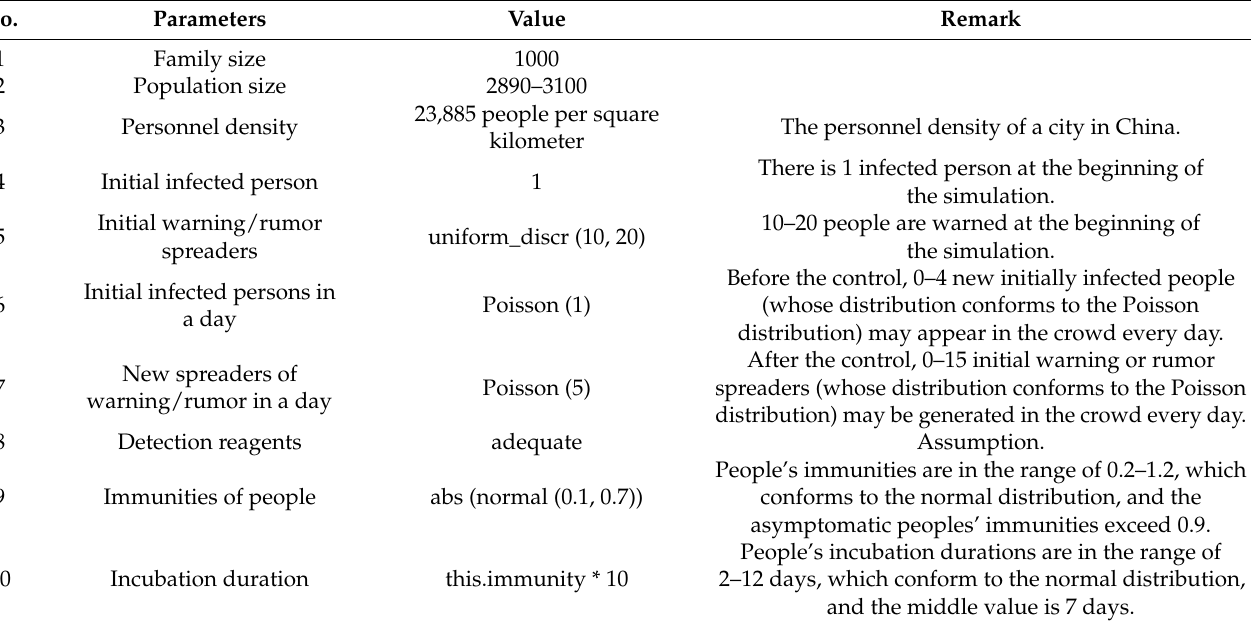
Table 1. The parameters in the scenario model. Some parameters are designed as probability distributions, including the discrete uniform distribution (uniform_discr), Poisson distribution, and normal